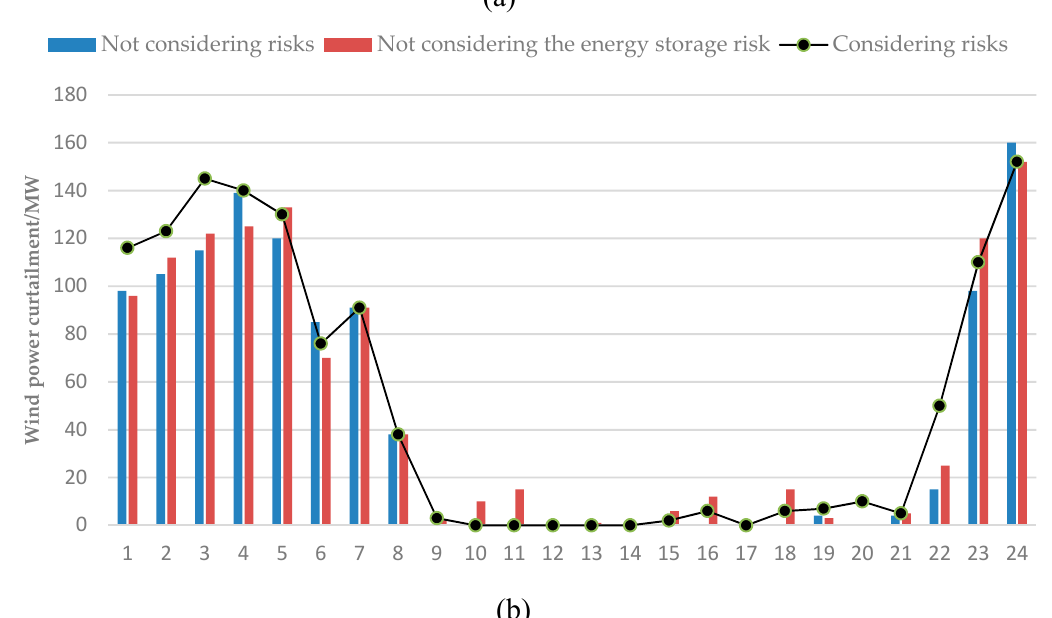
Figure 8. Residual capacity of battery energy storage and the abandoned air volume of wind power station each time in three scenarios.